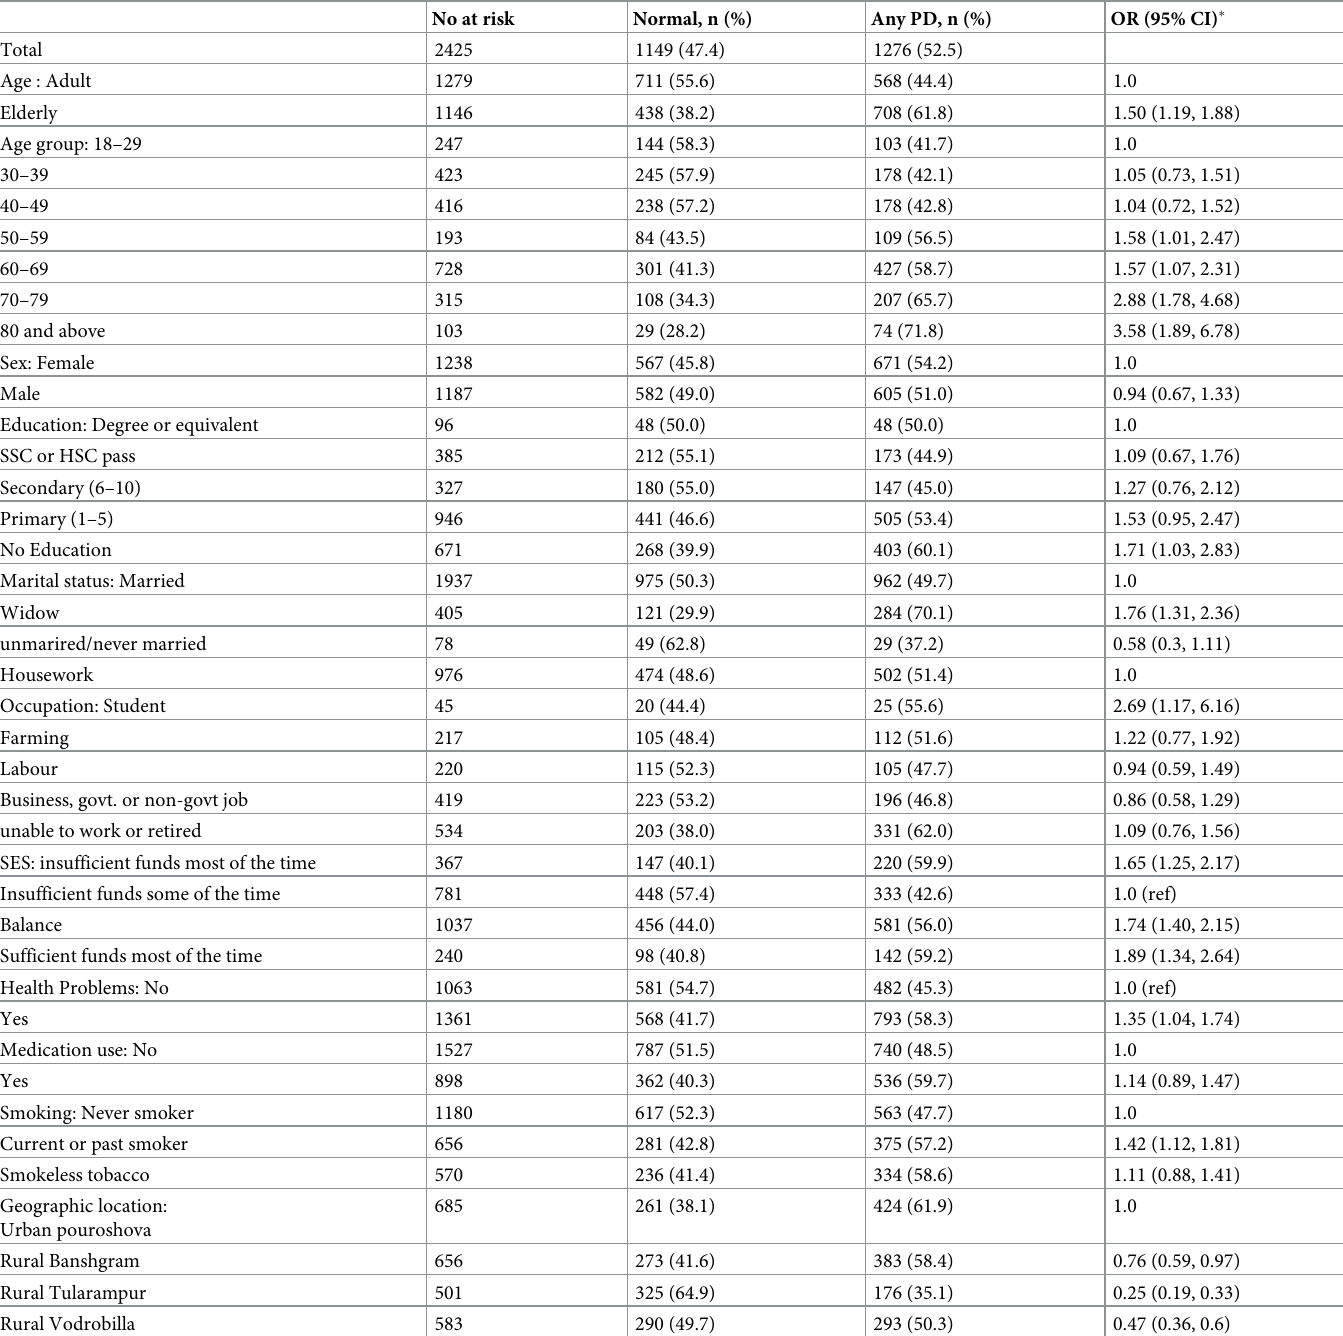
Table 2. Association of socio-demographic factors with any psychological distress in the total participants using binary regression